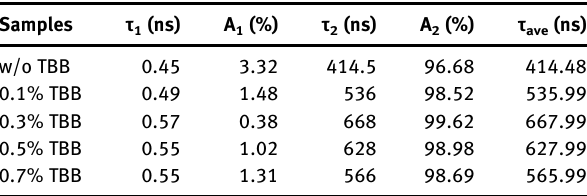
Table  : TRPL fi tting data of perovskite samples doped with different concentrations of TBB. Samples